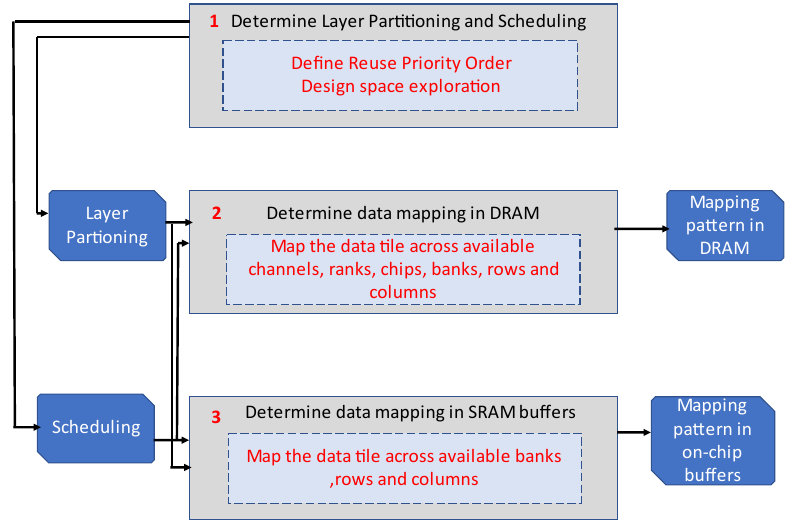
Figure 35. Operation flow of ROMANet [33].